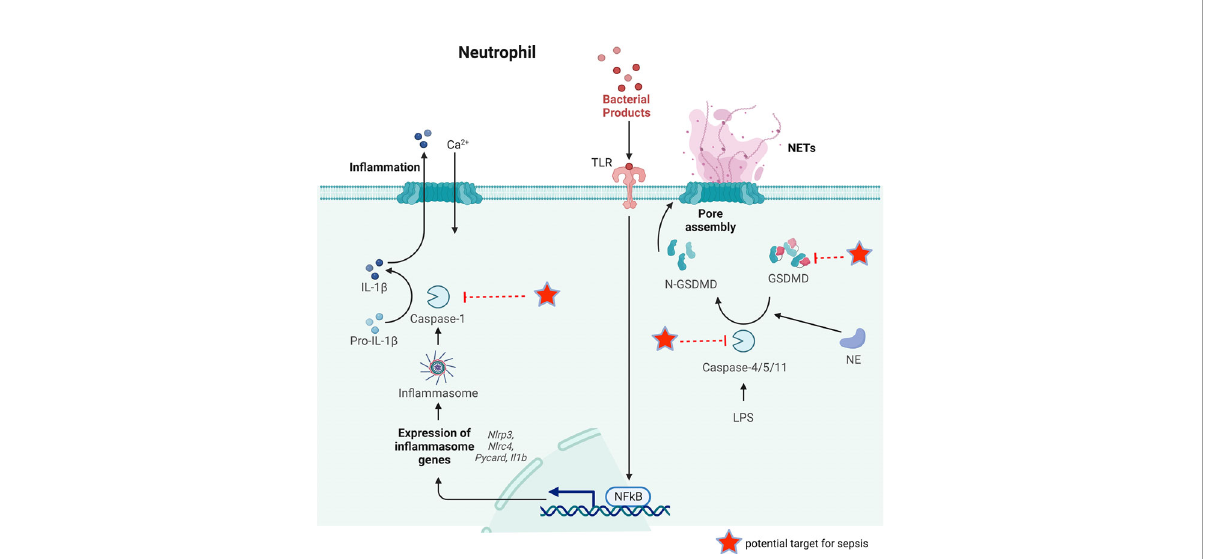
FIGURE 4 The key process of neutrophil pyroptosis in sepsis. In the classical pathway, pathogens, bacteria and other signals can recognize the intracellular NLR family and activate casepase-1 by forming in fl ammasome. Capsase-1 can cleave pro-IL-1 b to IL-1 b inducing in fl ammation. Whereas in the non-classical pathway, the participation of in fl ammasome is not necessary for the activation of caspase-4/5/11. Capsase-4/5/11 can cleave GSDMD to N-GSDMD and promote NET release. GSDMD can also be cleaved by NE to promote NETs release. Some possible targets for reducing NETs release during sepsis are pointed